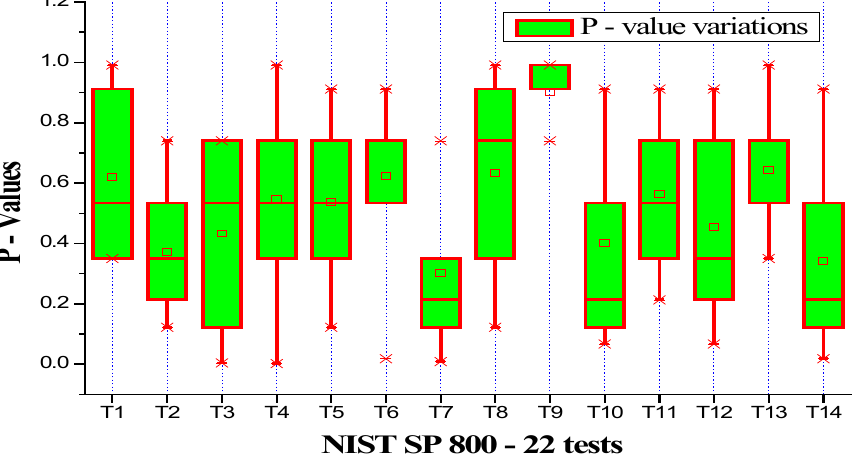
Figure 7. Box chart plot of the p -values of the conditioned true random bits. Table 7. TestU01—Linear Complexity Analysis. Test with Parameters